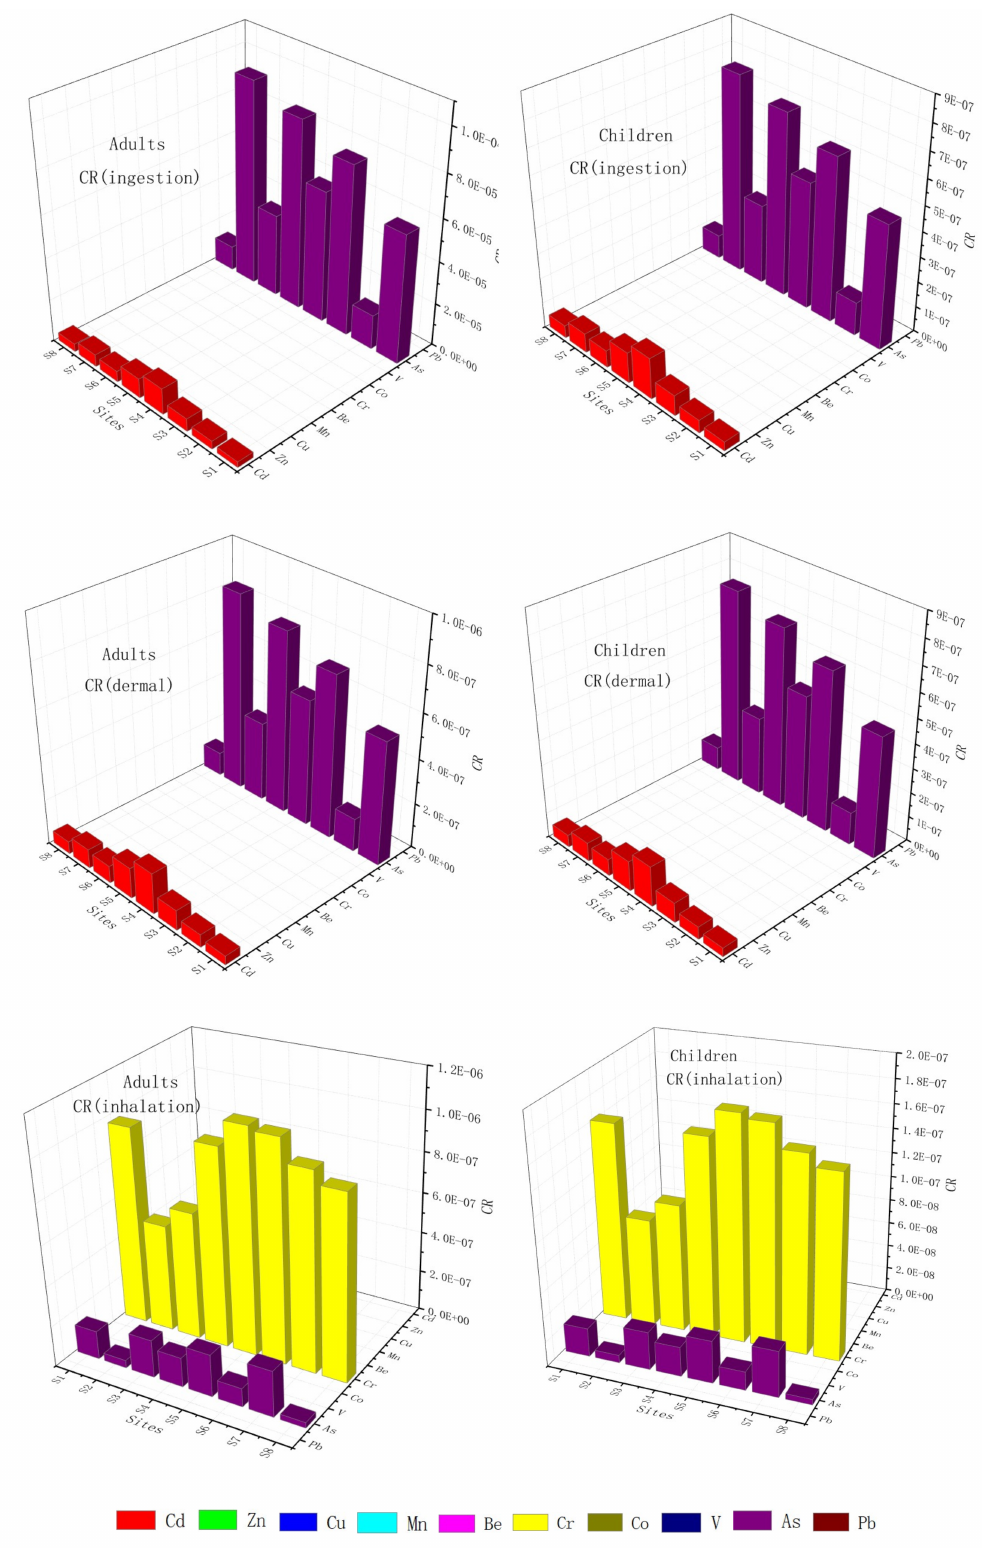
Figure 7. The hazard quotient (HQ), hazard index (HI) and carcinogenic risk (CR) with the study area in